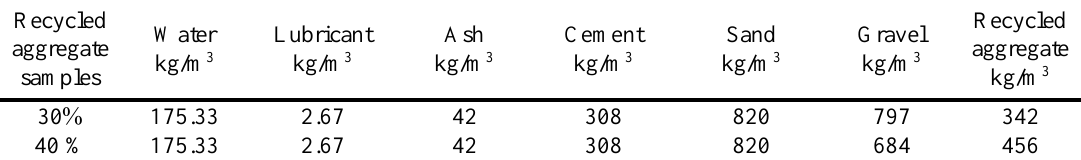
Table 11. Concrete mixing plan containing rice husk ash and recycled sand aggregate